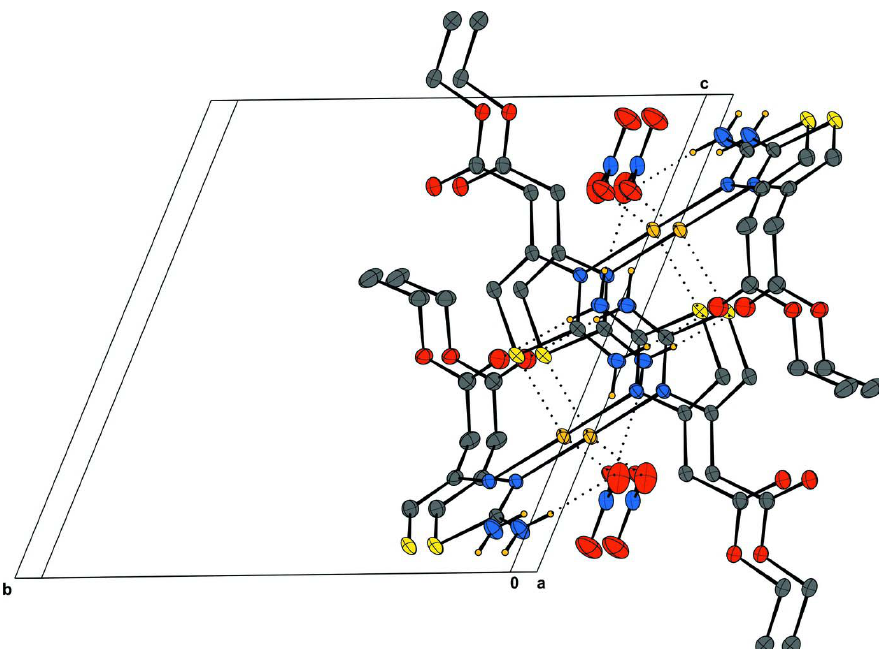
Figure 2 Partial packing view of (I), showing the formation of the pseudo dimer through weak Ag···S interactions and the two- dimensional network structure via intermolecular N—H···O hydrogen bonds. The weak interactions are represented as dashed lines. Hydrogen atoms not involved in hydrogen bonds were omitted for